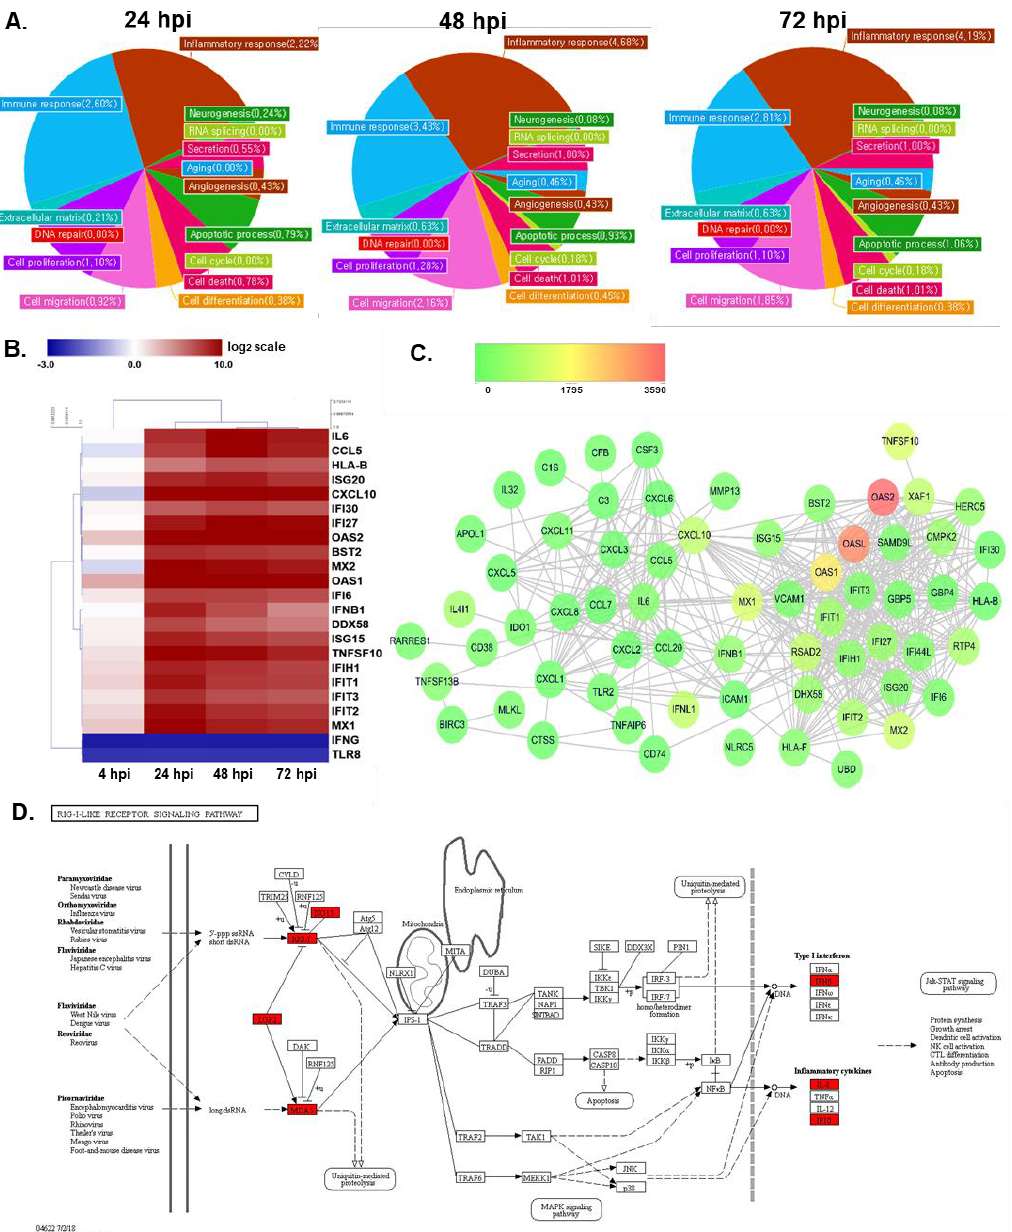
Figure 3. Comprehensive analysis of gene expression profiles of CVB3-infected hNPCs reveals changes in innate immune response genes. ( A ) Gene ontology ( B ) Heatmap indicating the log 2 fold change values of differentially expressed genes (DEGs) involved in immune responses in response to CVB3 infection of hNPCs, as determined by QuantSeq analysis. Hierarchical clustering was performed to group genes based on similar expression profiles, as indicated by the dendrograms (left). Up- and downregulated DEGs are indicated in red and blue, respectively. Time points are indicated below the panels. ( C ) Interferon-stimulated genes–protein interaction networks of DEGs in 48 hpi samples were constructed using Cytoscape. Nodes represent proteins and edges represent interactions between two proteins. Fold changes in the gene expression of the virus-infected groups was overlaid onto the nodes, as indicated by the color key. ( D ) GG analysis of 48 hpi sample resulted in a list of DEGs involved in RIG-I like receptor signaling pathways. Red, green, and white colors indicate significantly increased, significantly decreased, and unchanged gene expression in mock vs. CVB3-infected cells. DEGs were labelled on the map of RIG-I like receptor signaling pathways obtained from KEGG database with o ffi cial permission and guidance